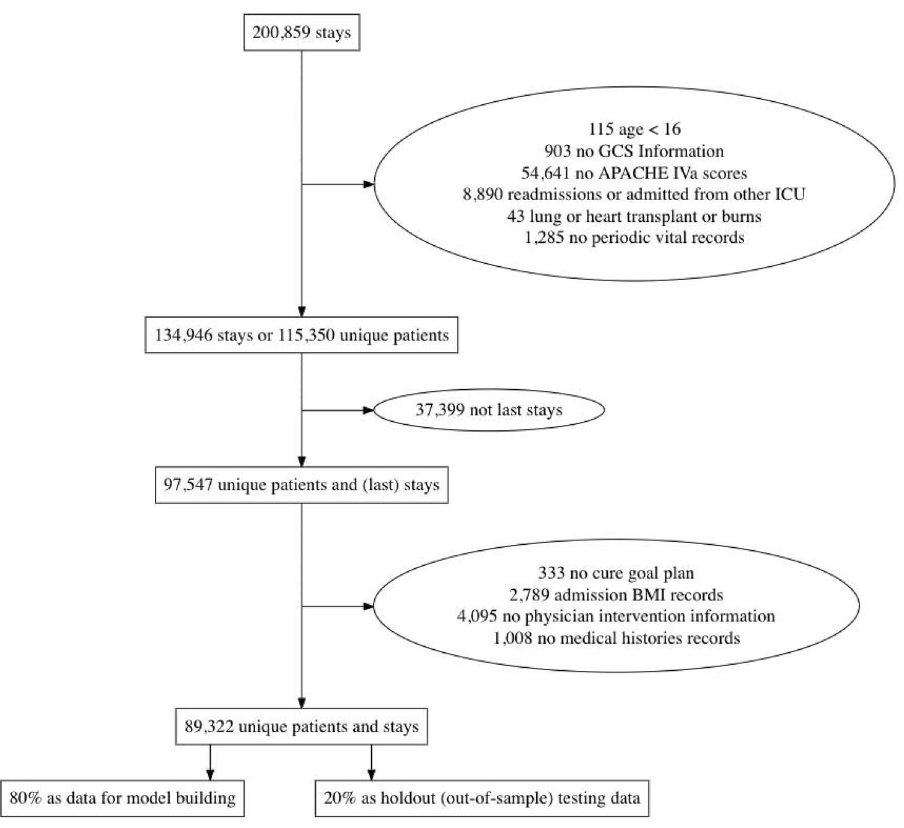
Figure 1. Flow chart of cohort selection from eICU